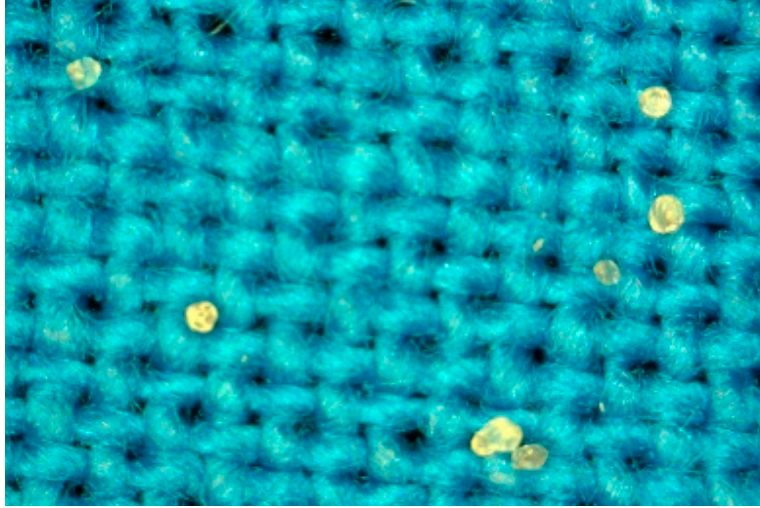
Figure 3. Textile material functionalized with microcapsules containing silver and zinc.